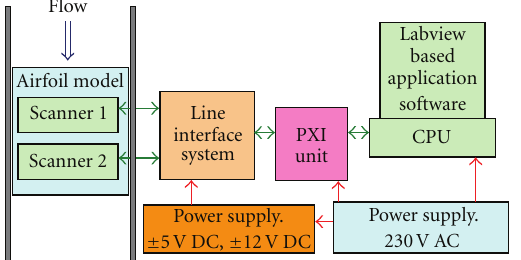
Figure 5: Measurement chain for surface pressure data acquisition.